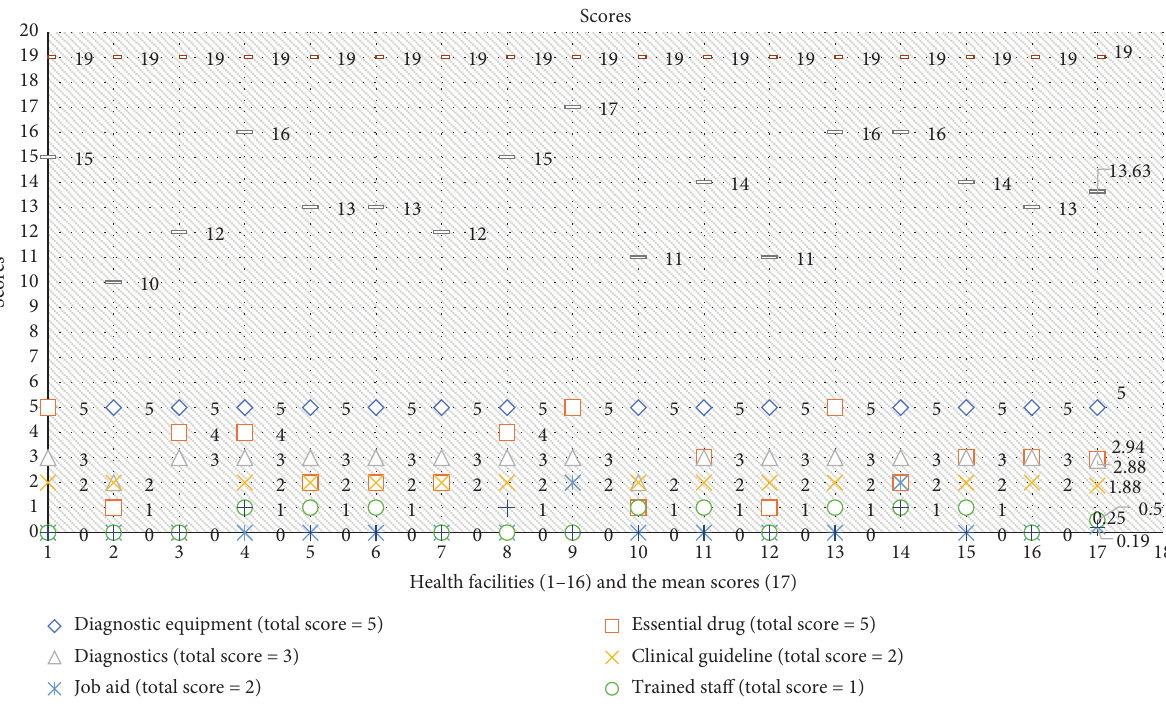
Figure 1: HFs’ readiness to manage HTN and diabetes (parameters, total maximal score, and total actual scores).